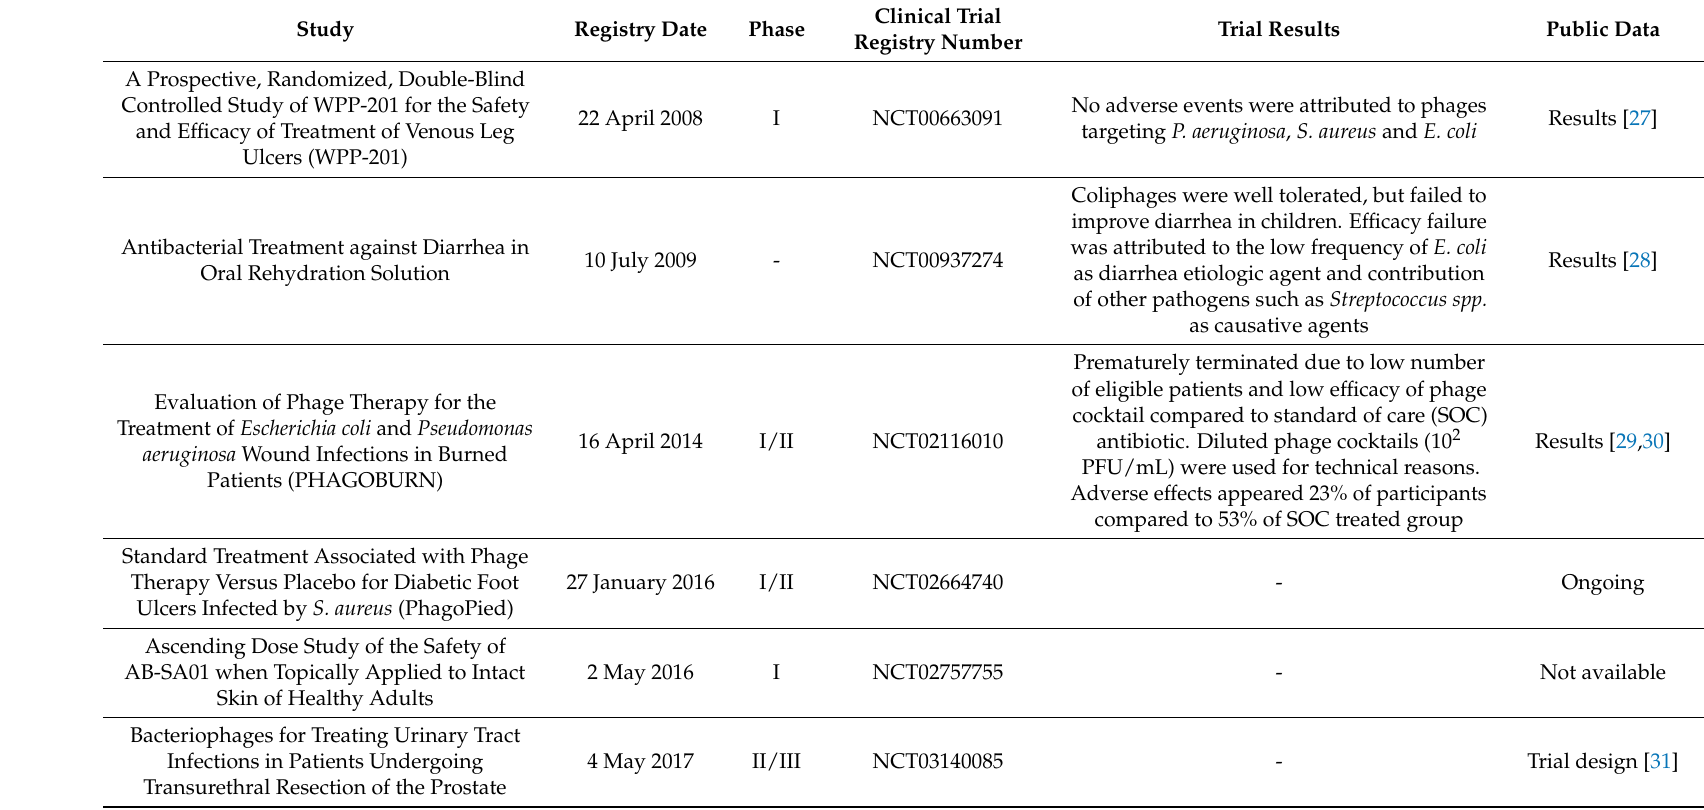
Table 1. Clinical trials of bacteriophages ranked according to registry